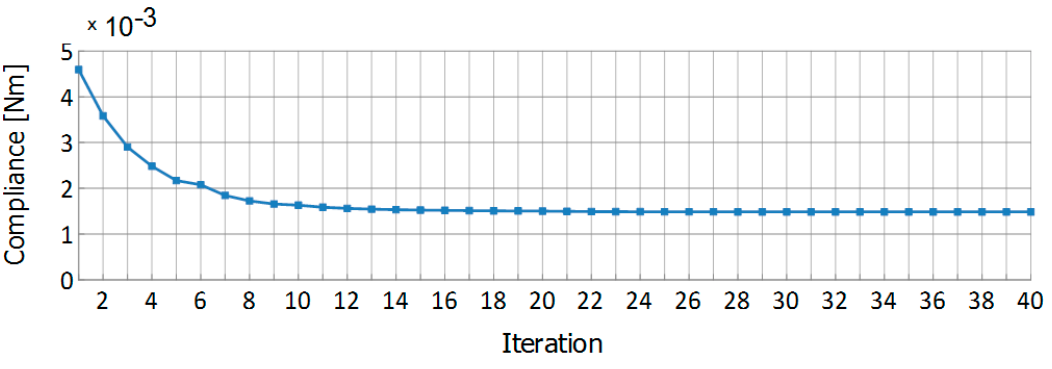
Figure 29. Iteration history for the knee structure.